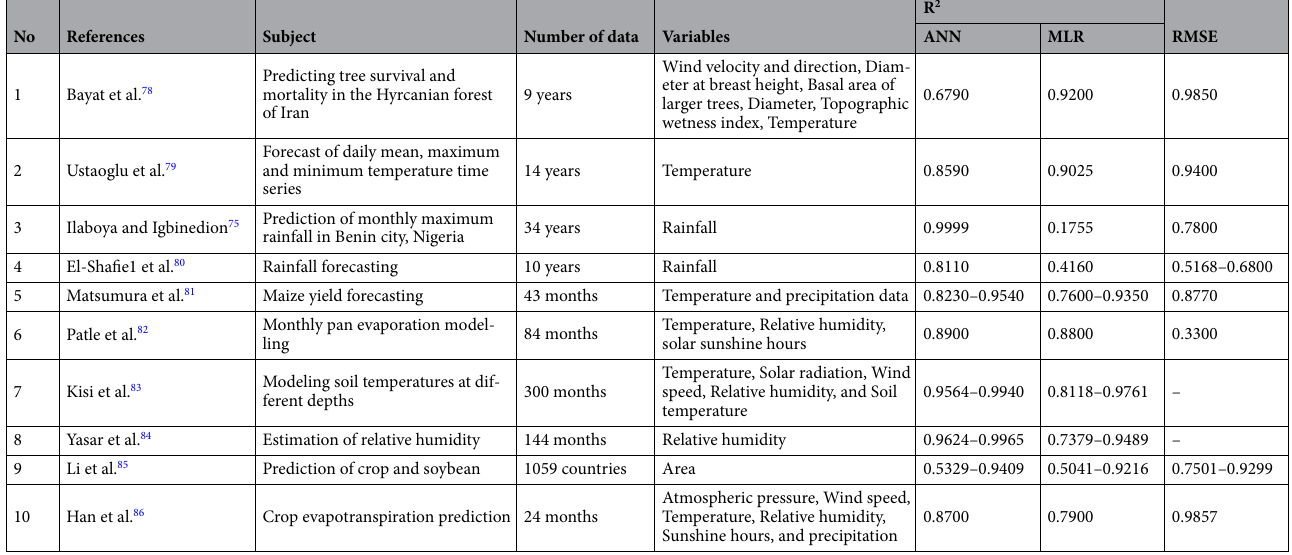
Table 6. Comparison of MLR and ANN models for other agricultural